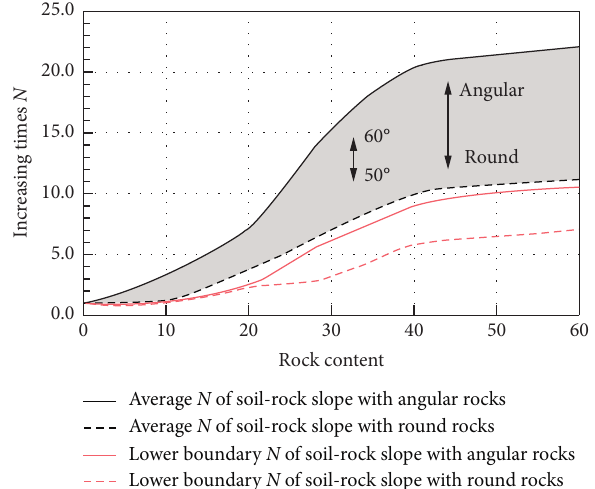
Figure 18: Advised ultimate loading increasing multiple N .